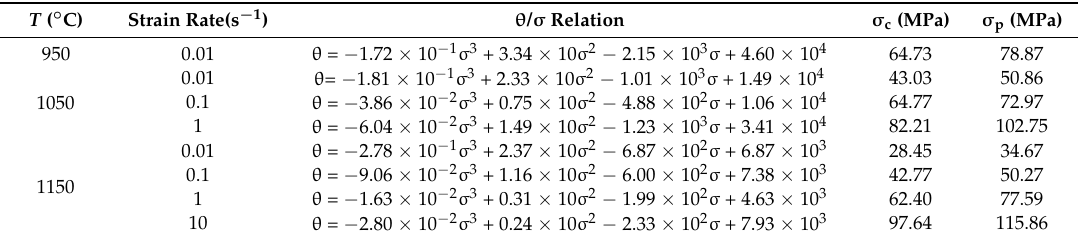
Table 2. Parameters fitted for the strain hardening rate as a function of flow stress.